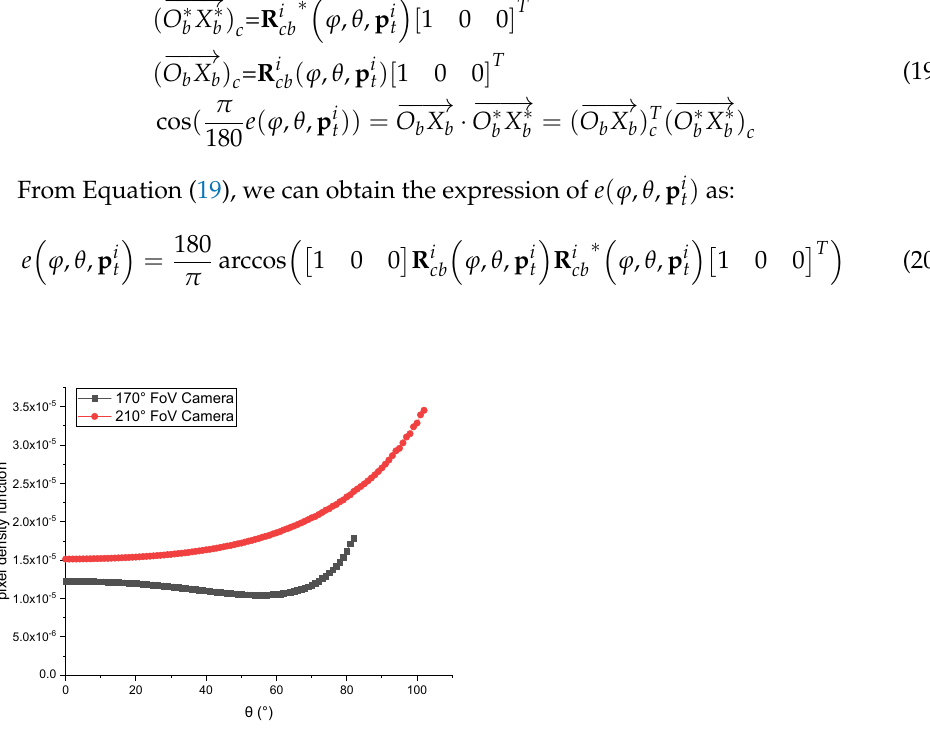
Figure 8. The pixel density function of 170° field of view (FoV) and 210° FoV camera with θ .